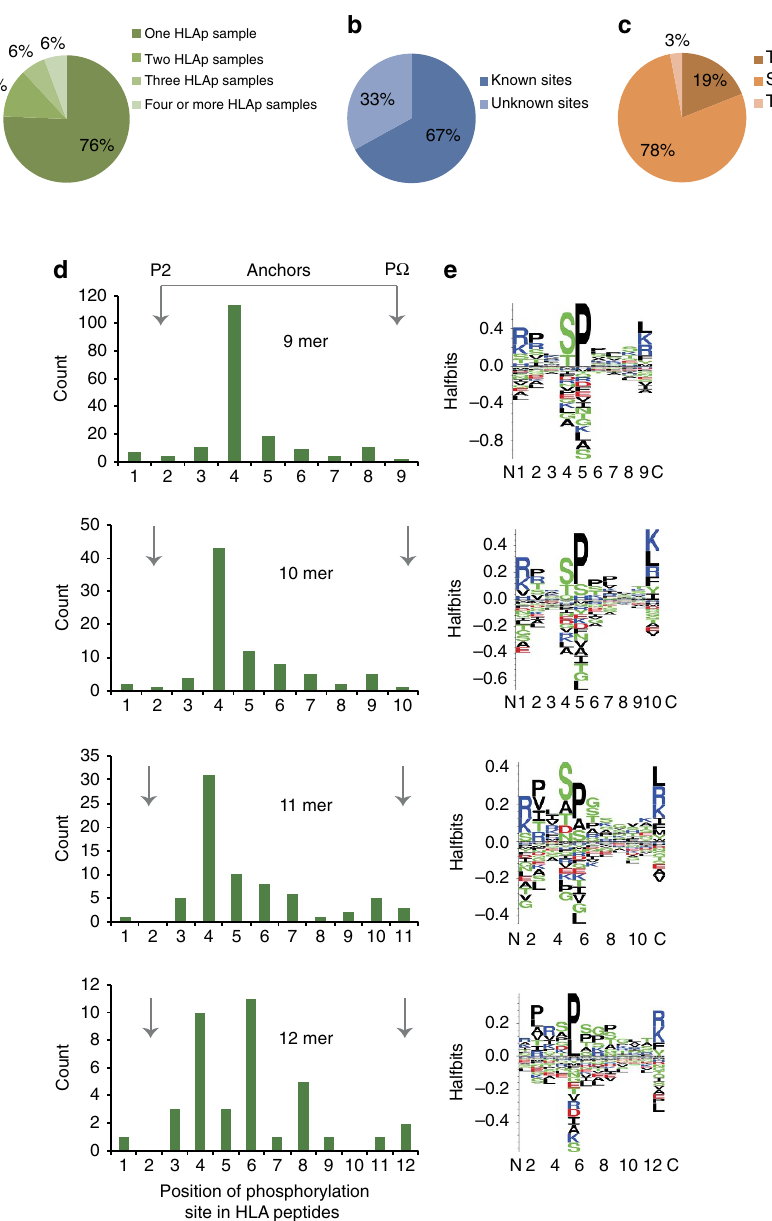
Figure 3 | Characterization of phosphorylation on eluted HLA peptides. Percentage of phospho-HLA peptides commonly detected in two or more patients ( a ) as well as percentage of known phosphorylation sites deposited on the PhosphoSitePlus database ( b ). Percentage of defined amino acids affected by phosphorylation within the phosphopeptide ligandome ( c ). Position of phosphorylation within the eluted phospho-HLA peptides according to the peptide length, from 9 mer to 12 mer peptides ( d ). Logo plots of residue frequency at each position of phospho-HLA peptides according to their length ( e